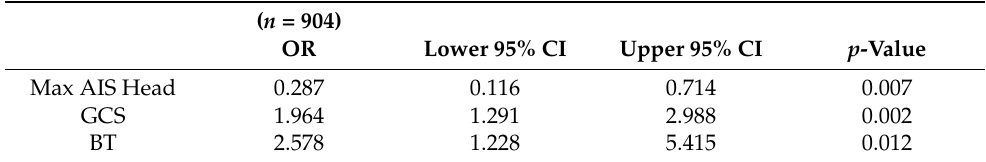
Table 5. Results of multivariate analyses for influencing death of the age group of <15 years. OR: odds ratio, 95%; CI: 95% confidence interval. ( n = 904)